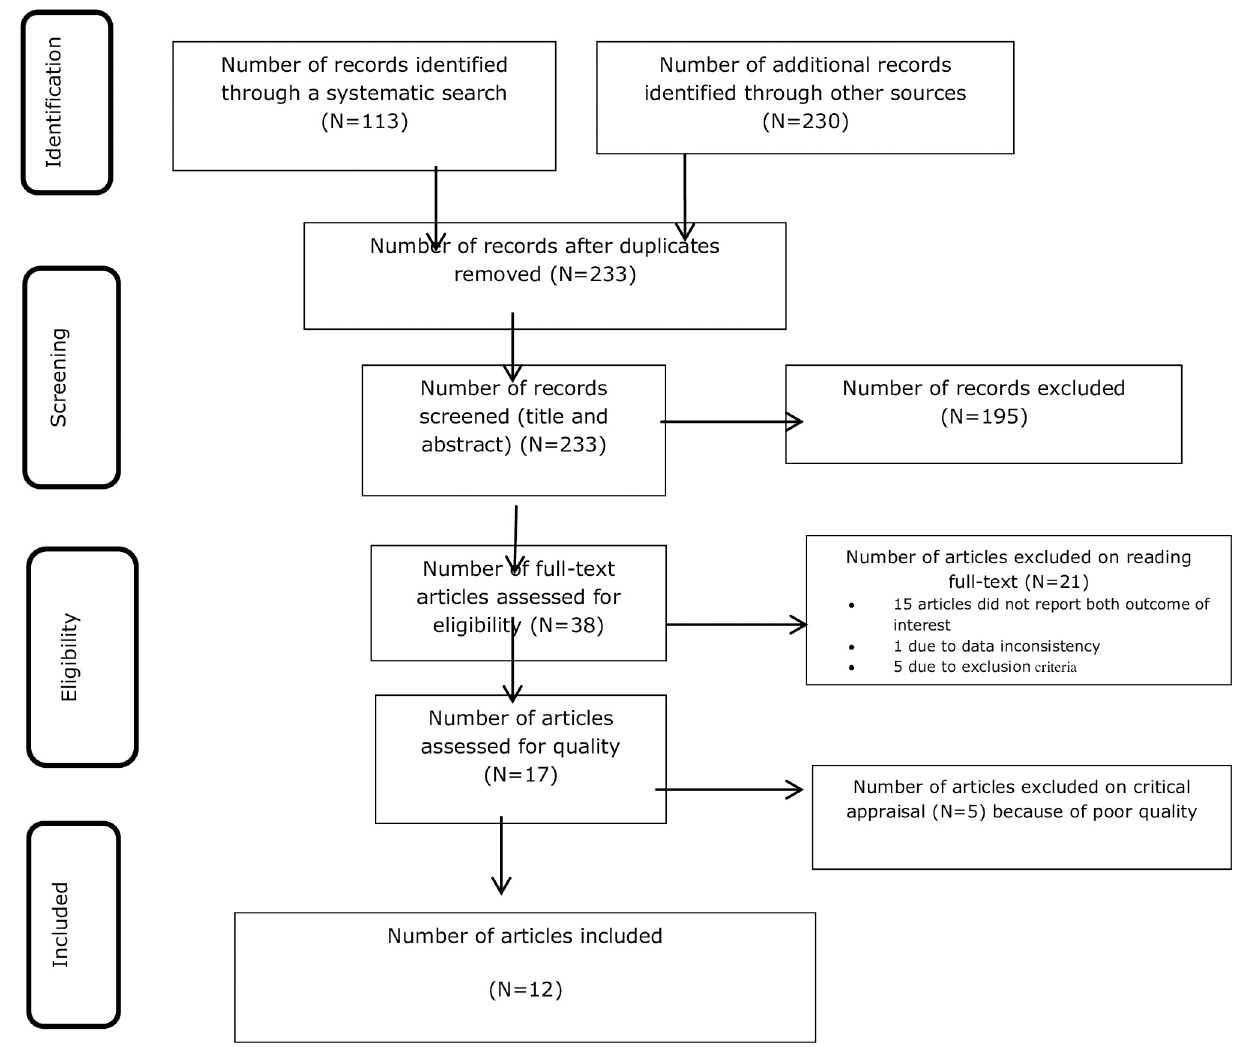
Fig 1. PRISMA flow diagram of treatment seeking delay among TB patients in Ethiopia,